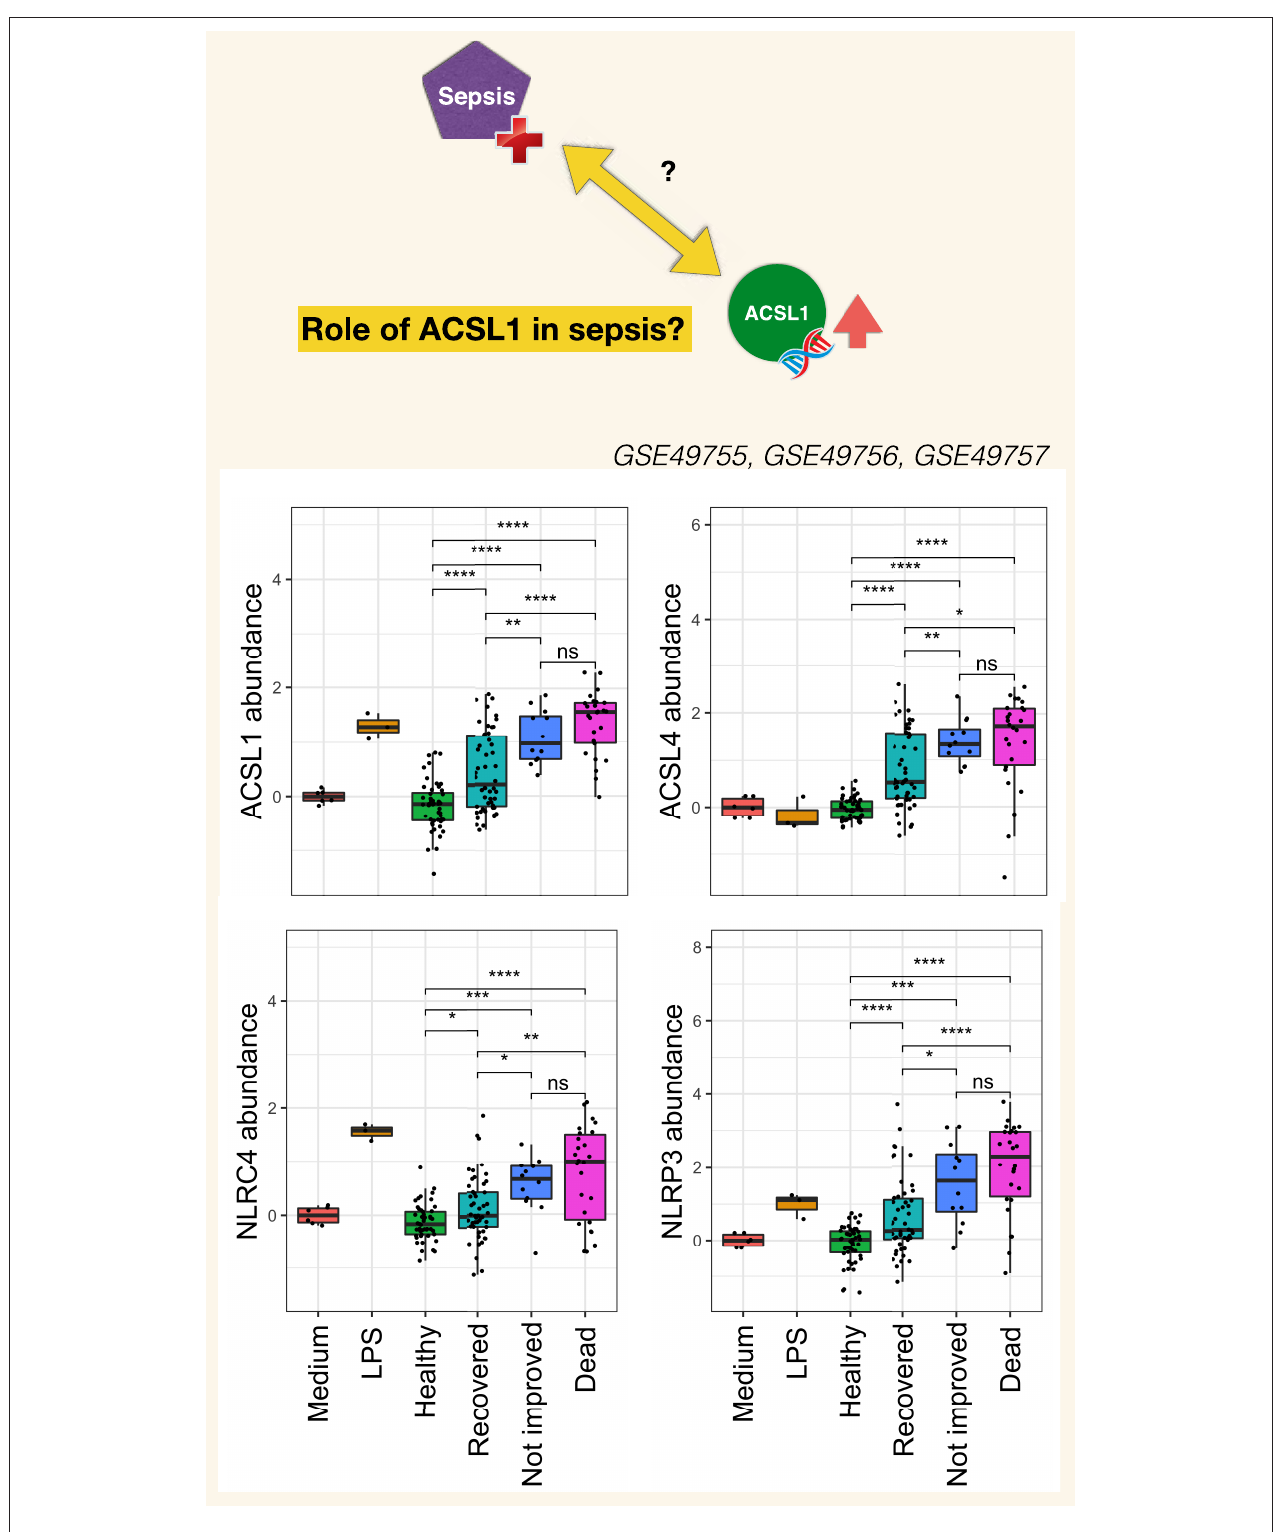
FIGURE 6 | Clinical significance of increases in ACSL1, ACSL4, and Inflammasome genes in the septic plasma neutrophil exposure dataset. For this figure all three datasets from this dataset series published as part of the work of Khaenam et al. were combined (see text for details). Fold changes over average of cells cultured with medium only are shown. Available clinical information was used to assign sepsis subjects to either one of three groups: Recovered, Not improved and Dead. Significance between the different groups is indicated above each graph with t -test * p < 0.05, ** p < 0.01, *** p < 0.001, **** p < 0.0001.